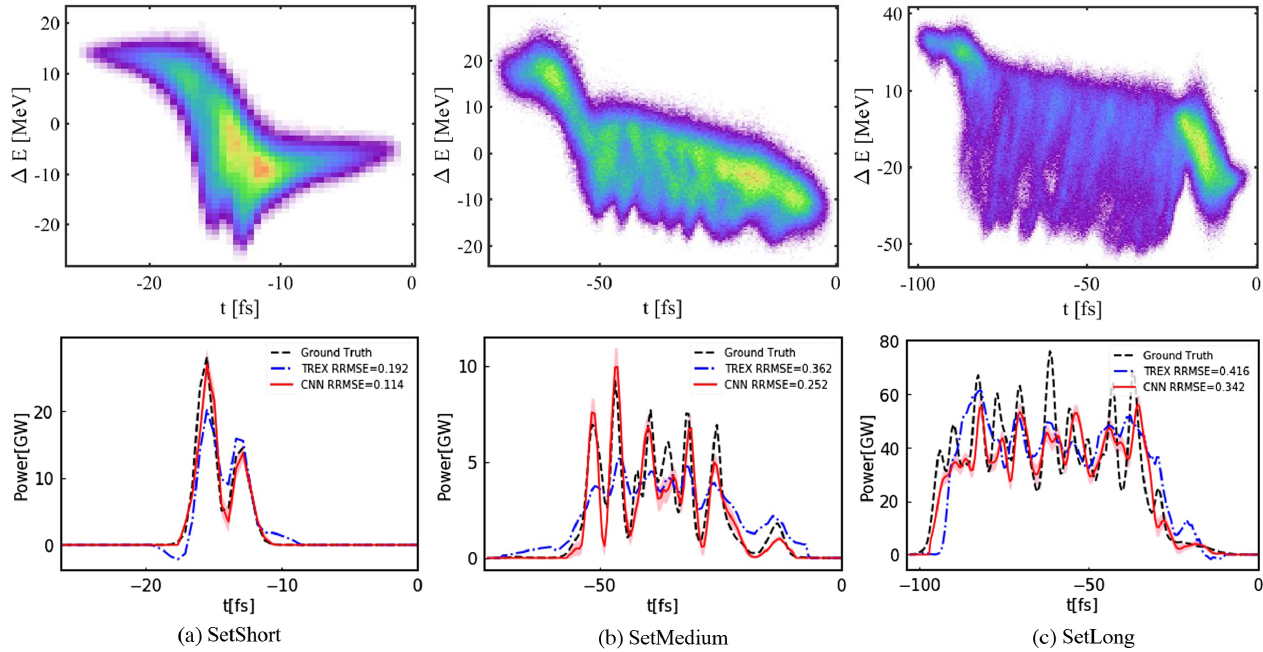
FIG. 2. The training simulations and corresponding reconstruction results. The left/center/right three plots are from the Setshort/ medium/long. The upper figures are the simulated output after GENESIS and ELEGANT , and lower plots are the comparisons between the simulated ground truth, TREX algorithm, and CNN prediction. The simulated x-ray power is smeared by convolving with a Gaussian function ( σ ¼ 0 . 5 fs), while the electron phase-space resolution is determined by the ELEGANT transport (rms ≈ 1 . 3 fs). The TREX algorithm works with a lasing-off phase-space pool generated from experimental records and evaluates the RRMSE energy spread between lasing-on/off. The error bar of the CNN prediction represents the standard deviation of the network output using the dropout method [34]. The undulator lengths for the three sets are 33 = 49 = 90 m respectively, corresponding to approximately saturation for SetShort and SetMedium, and deep saturation for SetLong.